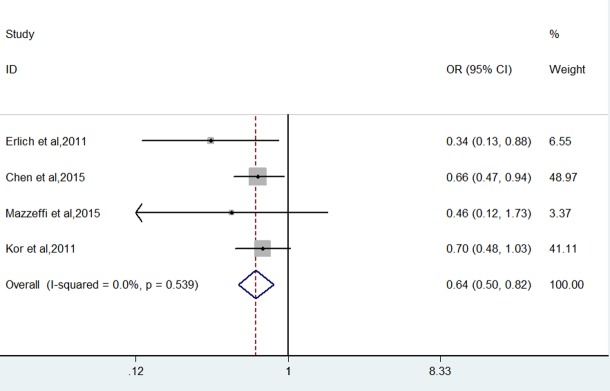
Forest plot showing the effect of anti-platelet therapy on newly developed ARDS/ALI.